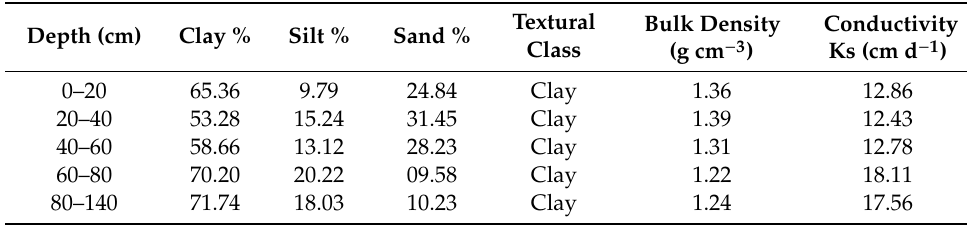
Table 1. Physical properties of the soil in the experimental field at Malaysian Agricultural Research and Development Institute (MARDI).